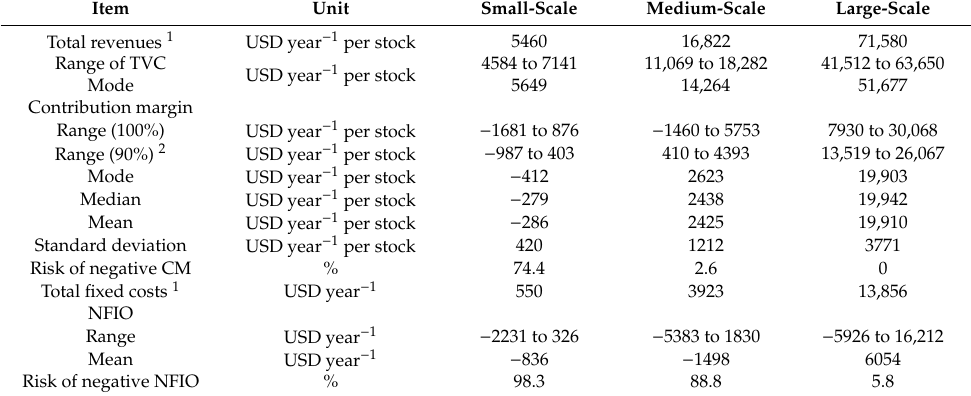
Table 10. Results of Monte Carlo simulation for contribution margin and net farm incomes from operations of three types of individual farms in the Ili Delta in worst case